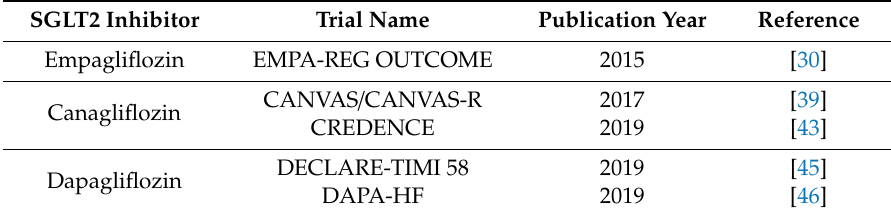
Table 3. Cardiovascular outcome trials (CVOTs) with SGLT2